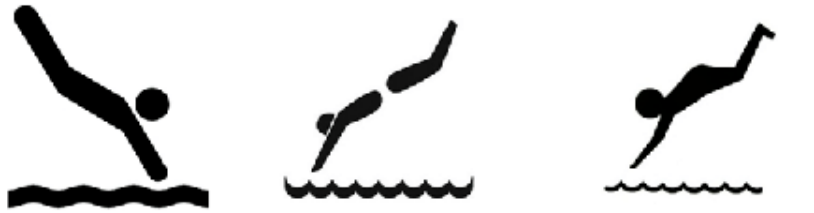
Figure 1. The three clipart images of a figure diving into water that were included in the photo sort task.